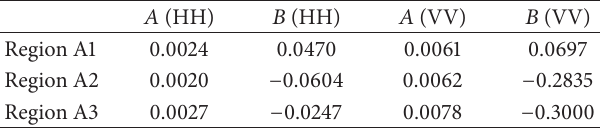
Table 2: The calibration coefficients for the first principal compo- nent of HH and VV polarized X-band marine radars in Regions A1– A3.